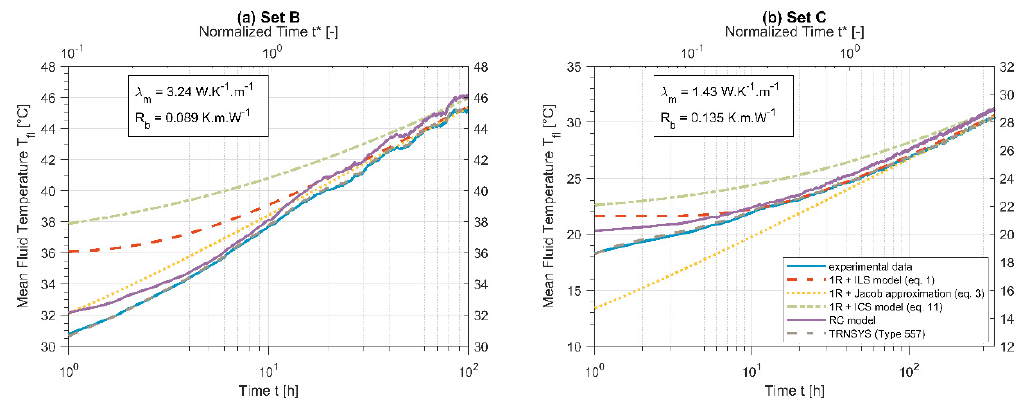
Figure 6. Evolution of the experimental fluid temperatures, temperatures from the analytical approaches, TRNSYS DST model and the RC model for ( a ) set B (from 1 h to 100 h), ( b ) set C (from 1 h to 350 h).